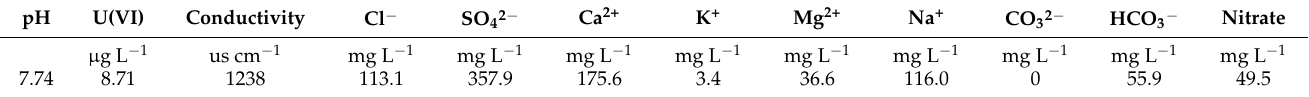
Table 2. Physical and chemical parameters of groundwater